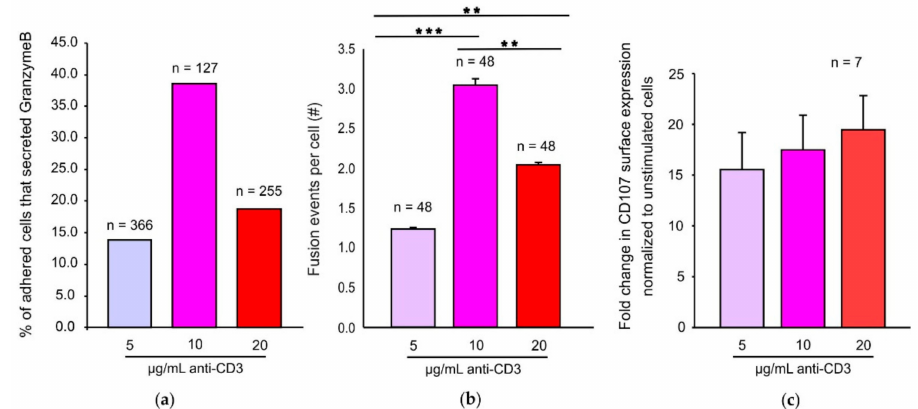
Figure 1. An optimum TCR trigger is required for maximal cytotoxic granule (CG) fusion e ffi ciency in supported planar bilayers. ( a ) Percentage of adhered cells that secreted granzyme B. n = number of adhered cells. ( b ) Number of fusion events per cell when stimulated with 5, 10, or 20 µ g / mL anti-CD3. n = number of cells that secreted granzyme B. ( c ) Fold change in CD107 degranulation normalized to constitutive degranulation occurring upon varying stimuli. n = number of experimental repeats. Error bars represent mean ± SEM. ** p < 0.01; *** p < 0.001; ns, non-significant ( p >